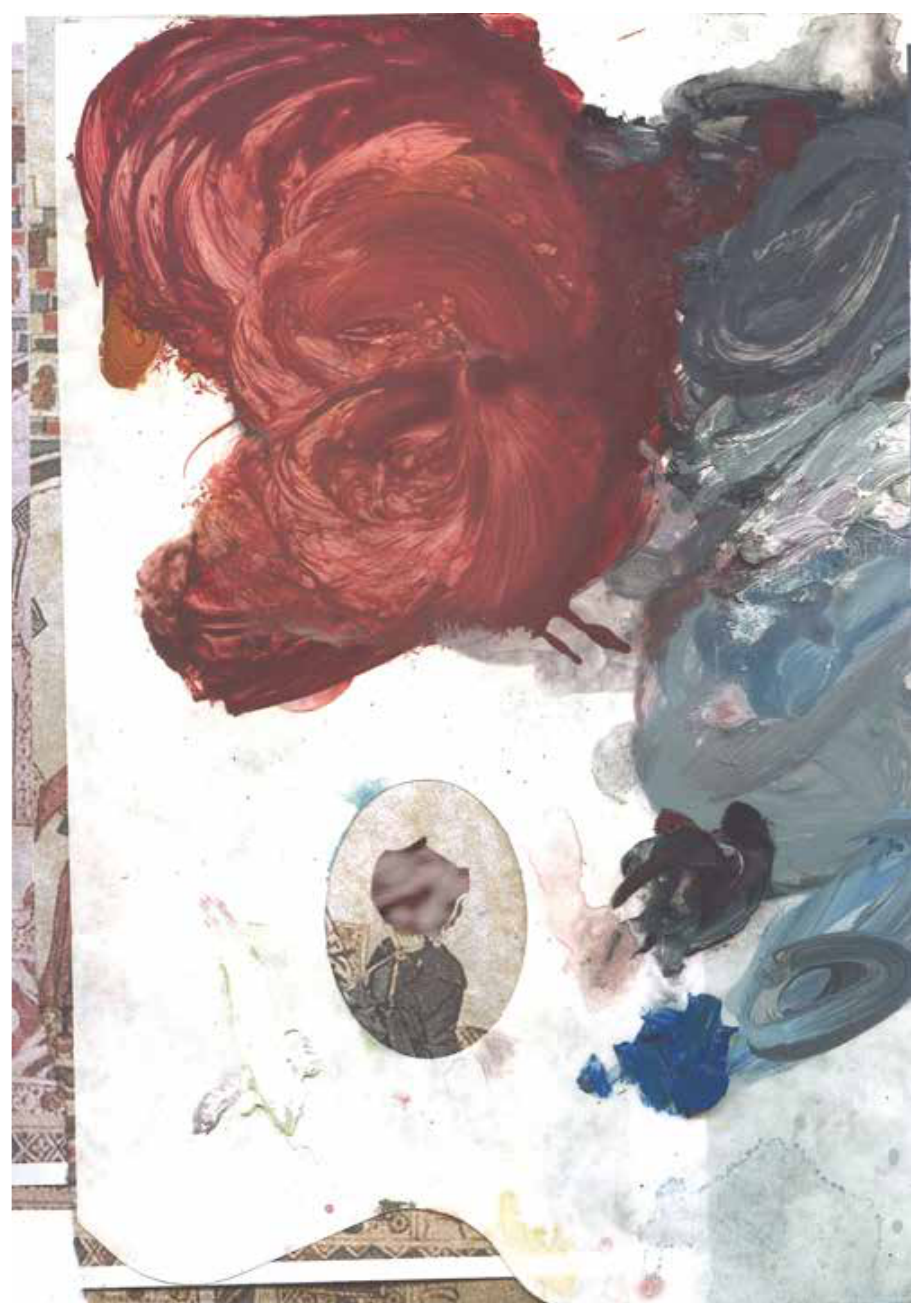
Figure 9: Barbara Ellmerer, 2018. Target Image, BE IP1. Source: Nils